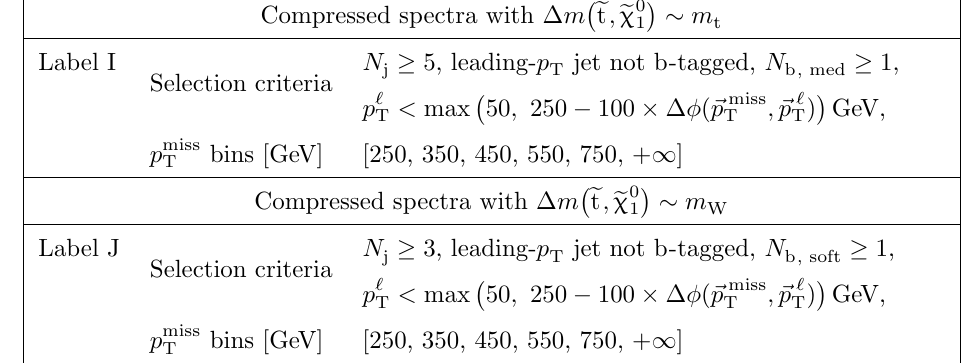
Table 3 . De(cid:12)nitions of the total 10 search regions targeting signal scenarios with a compressed mass spectrum. Search regions for (cid:1) m letter I and J, respectively. The symbol p ‘ neighboring pair of values in the p miss